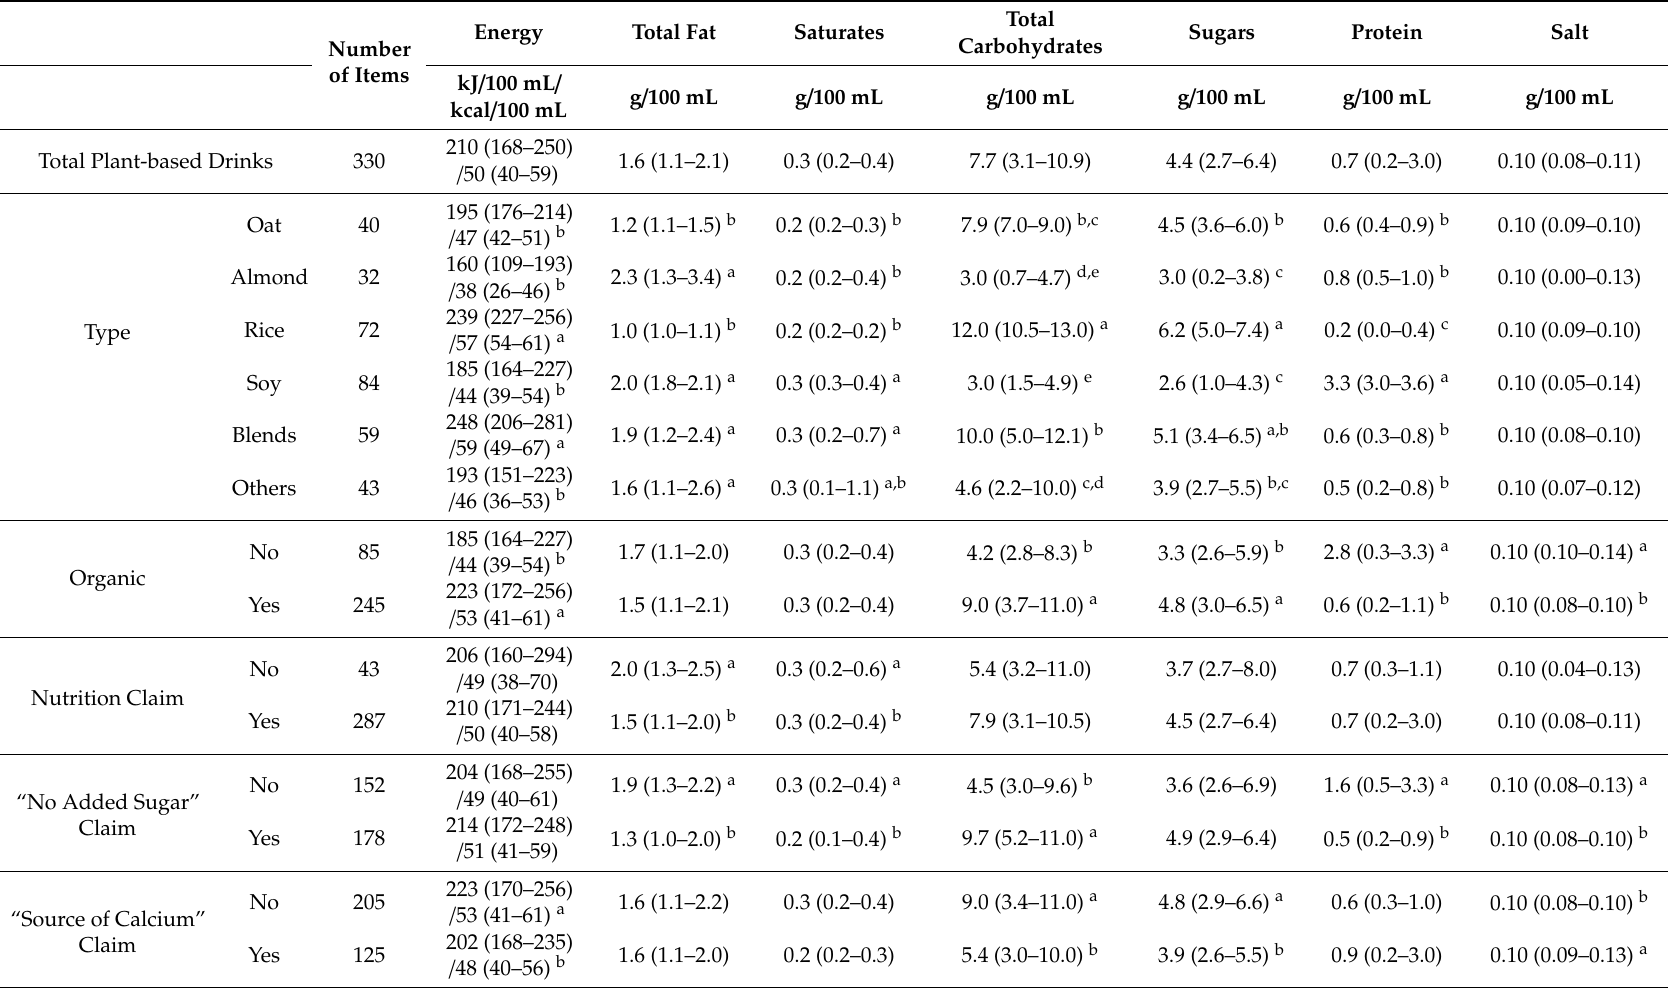
Table 1. Mandatory nutrition declaration across plant-based drink